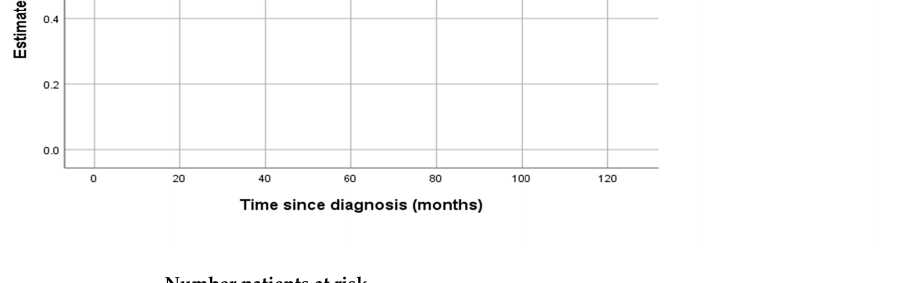
Number patients at risk.